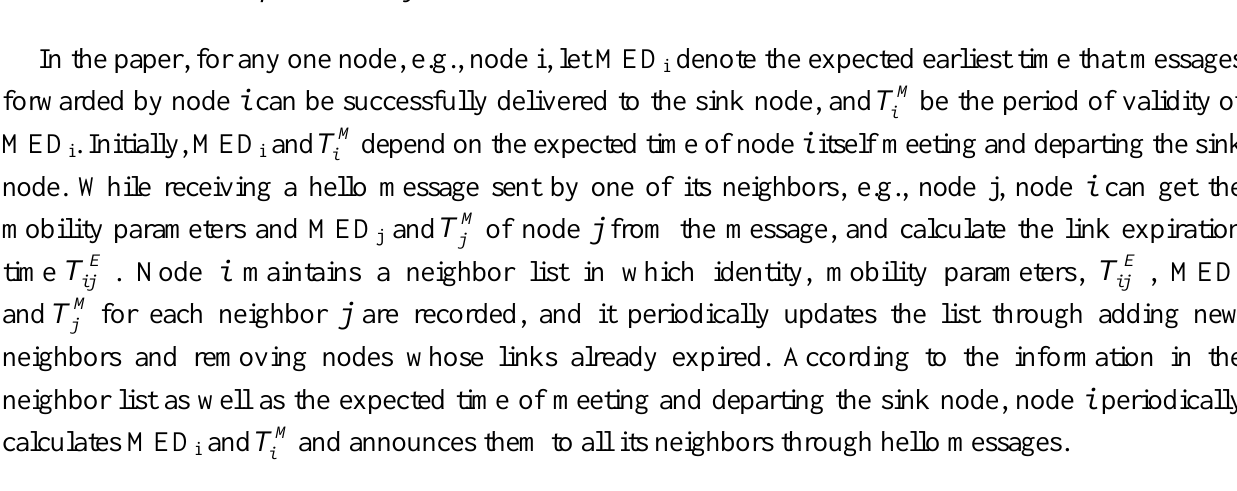
Figure 2. Illustration of computing nodes’ MED and expiration